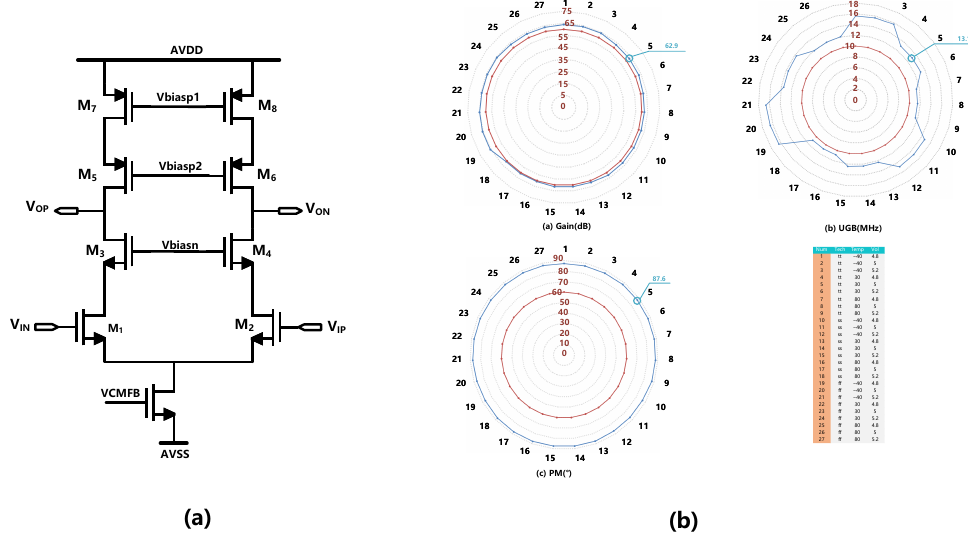
Figure 11. ( a ) Schematic of the second OTA. ( b ) The PVT simulation result of the second